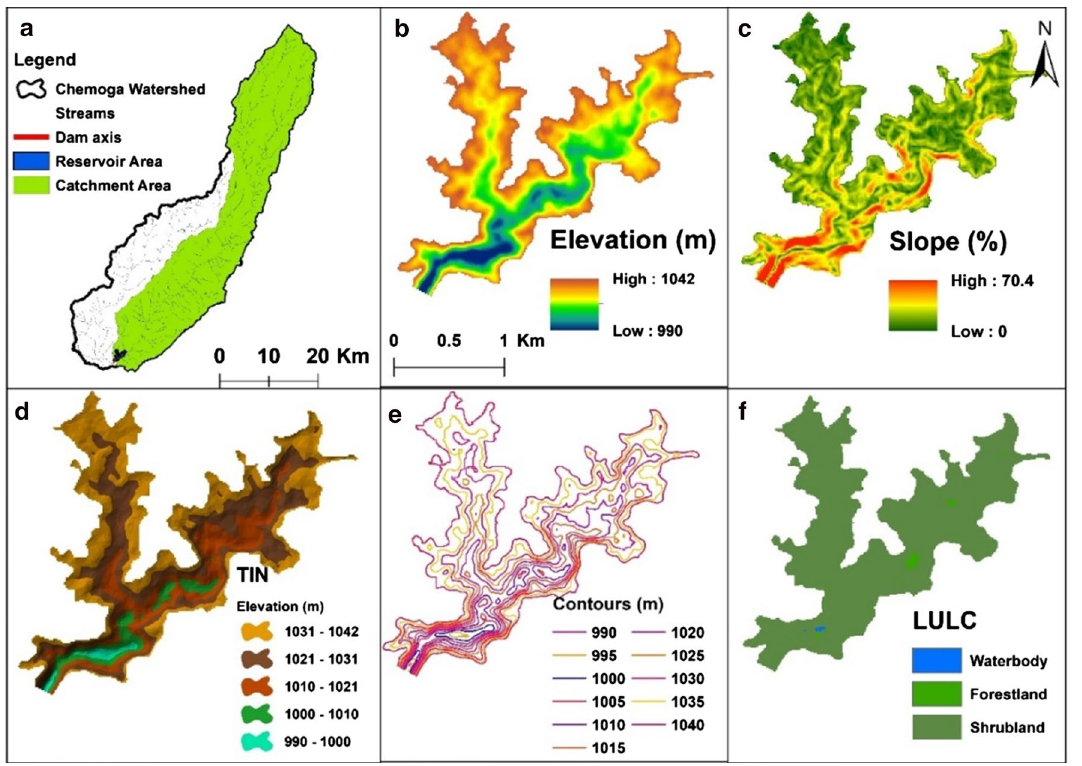
Fig. 22 Evaluation parameters for proposed Dam site 6: a Catchment area b DEM c slope d triangulated irregular network (TIN), e contours, f